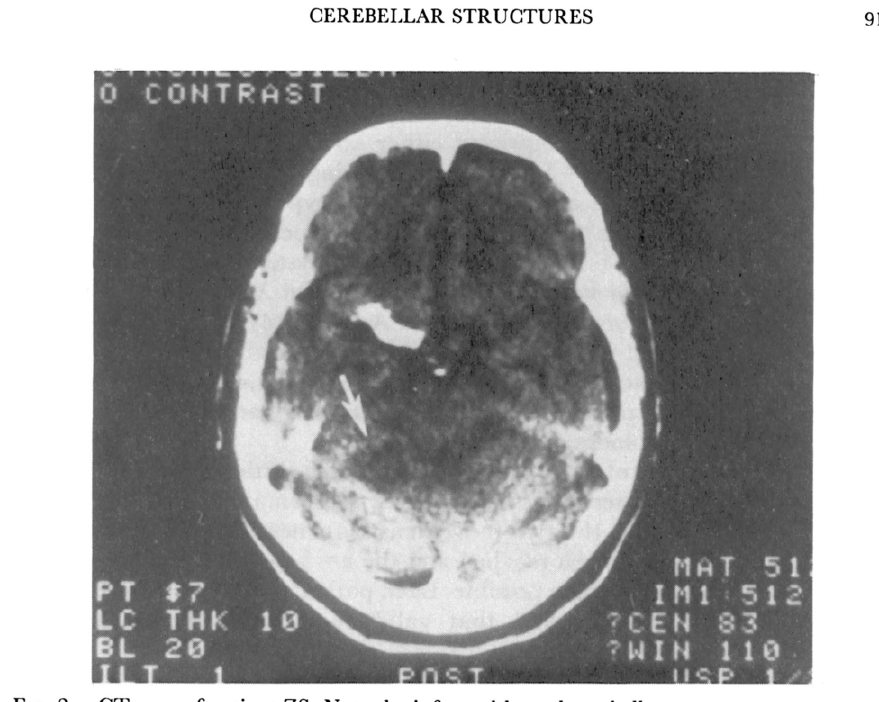
FIG. 2. CT scan of patient ZS. Note the infarcted lateral cerebellar